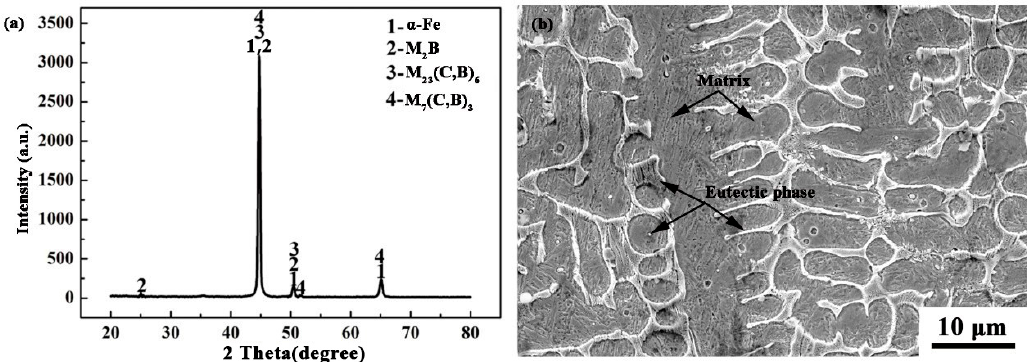
Figure 7. The XRD result and SEM morphology of the dendrite at the middle: ( a ) XRD result; ( b ) SEM